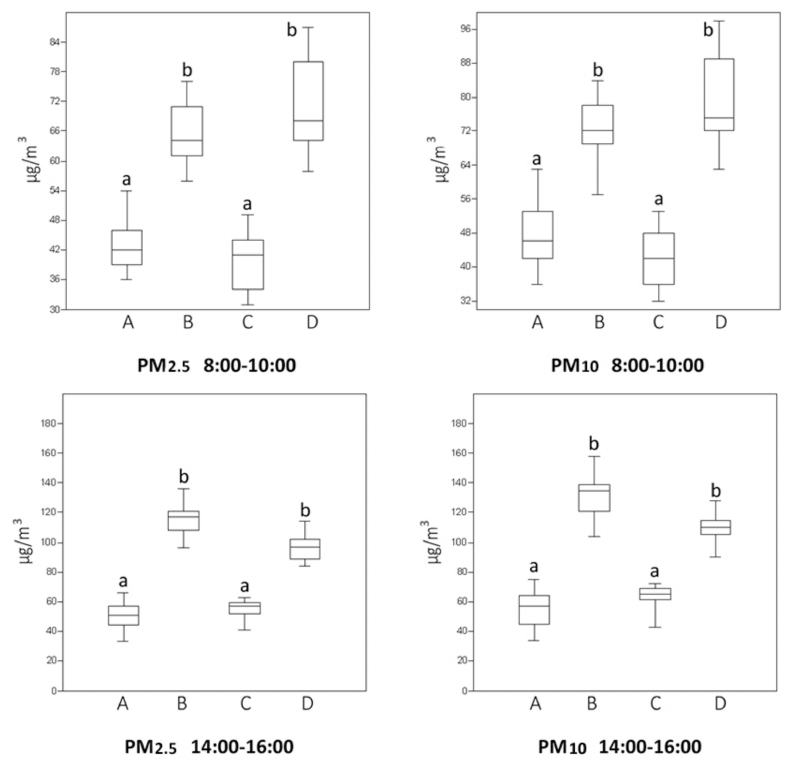
Figure 2. Mean PM 2.5 and PM 10 ( µ g/m 3 ) concentrations of in the morning and evening on the studied sections of the road to schools from all measurement points. a, b—homogeneous groups, significant differences at p < 0.05. Letters A–D refer to school’s symbols.